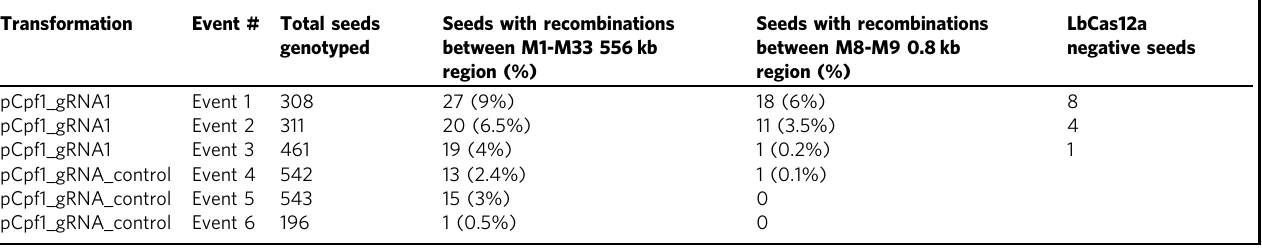
Table 2 The BC1-F1 seeds with chromosomal recombination identi fi ed at the gRNA1 target site grouped by F1-T0 plants (events).